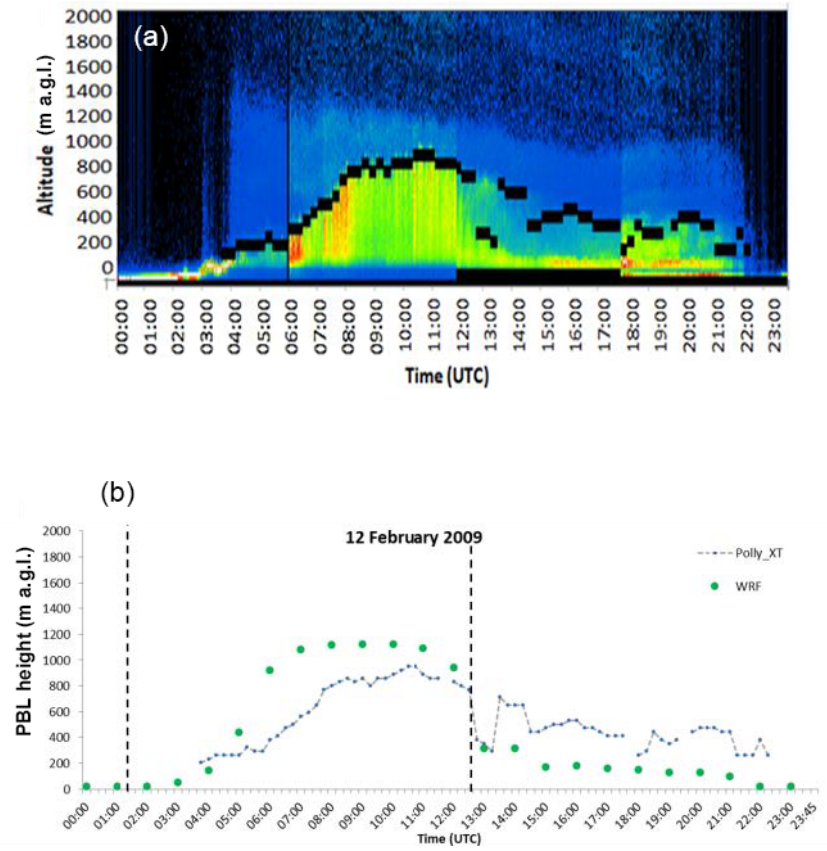
Figure 3. Evolution of the PBLH observed on 12 February 2009. Range-corrected signal (a) at 1064nm as measured with FMI–Polly XT . Black lines indicate 15min PBLH, while black zones in the lower part of the figure indicate the extent of the signal cutoff area. The color scale is normalized on a 6h basis, with red and yellow indicating a higher aerosol load, while green and blue indicate a lower load. PBLH (b) as given by the FMI–Polly XT and WRF (vertical lines indicate sunrise and sunset